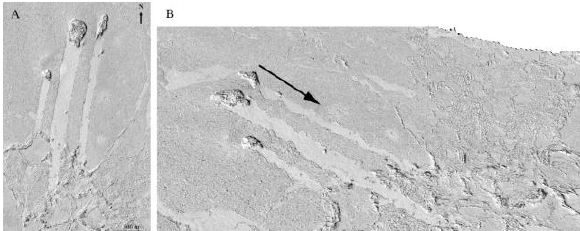
Figure7. The narrow traces behind the obstacles. (A) The length-width ratios of the traces are almost 10:1 measured in the sub set of HiRISE image ESP_033622_1845_RED.jp2. (B) The DTM derived from stereo images of D16_033622_1845_XN_04N206W.IMG and